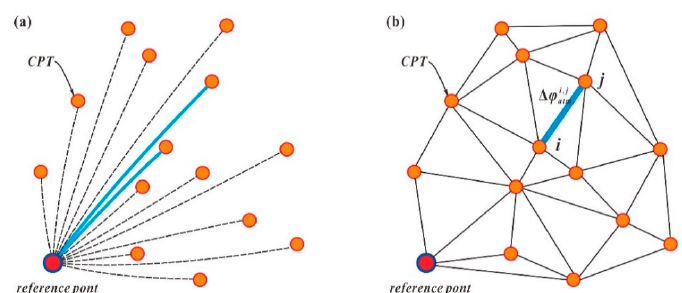
Figure 3. Atmospheric correction methods for continuous monitoring: ( a ) traditional atmospheric correction method for continuous monitoring, which is easily affected by the long distance between the monitoring points and the reference point; and ( b ) atmospheric correction method based on an irregular triangular network.